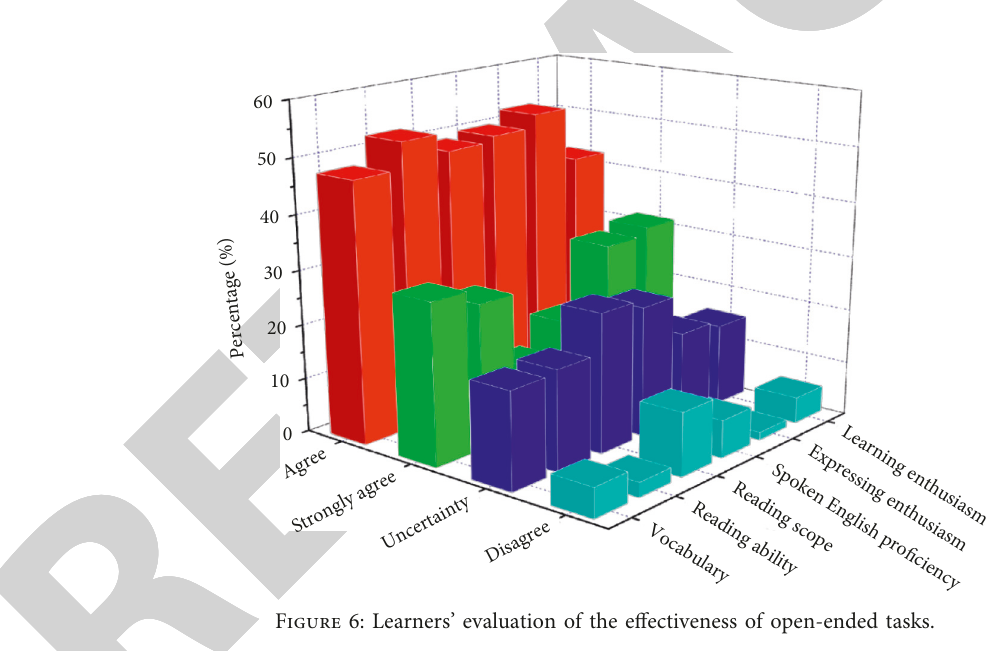
Figure 6: Learners’ evaluation of the effectiveness of open-ended